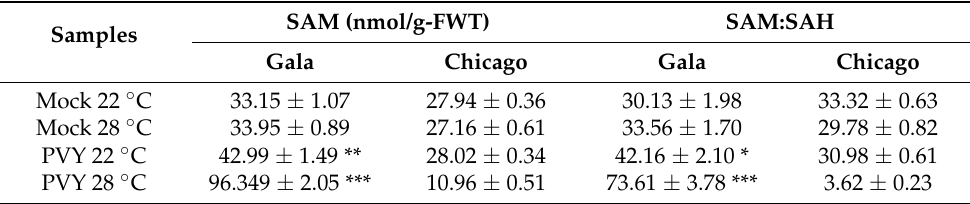
Table 2. SAM levels and SAM:SAH ratio in PVY-infected Gala and Chicago plants at 8 dpi. SAM (nmol/g-FWT) SAM:SAH Samples Gala Chicago